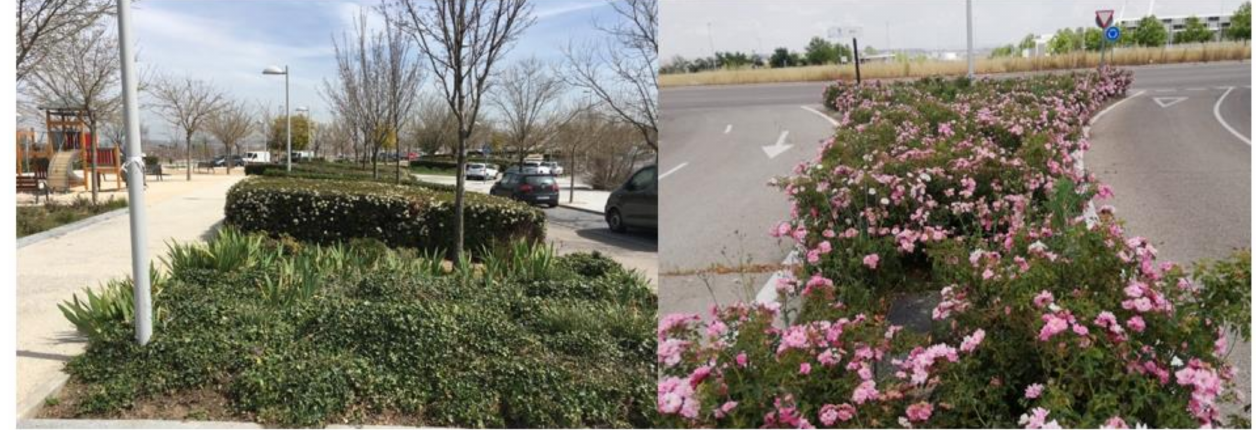
Figure 5. Distribution of plant typologies in parks.